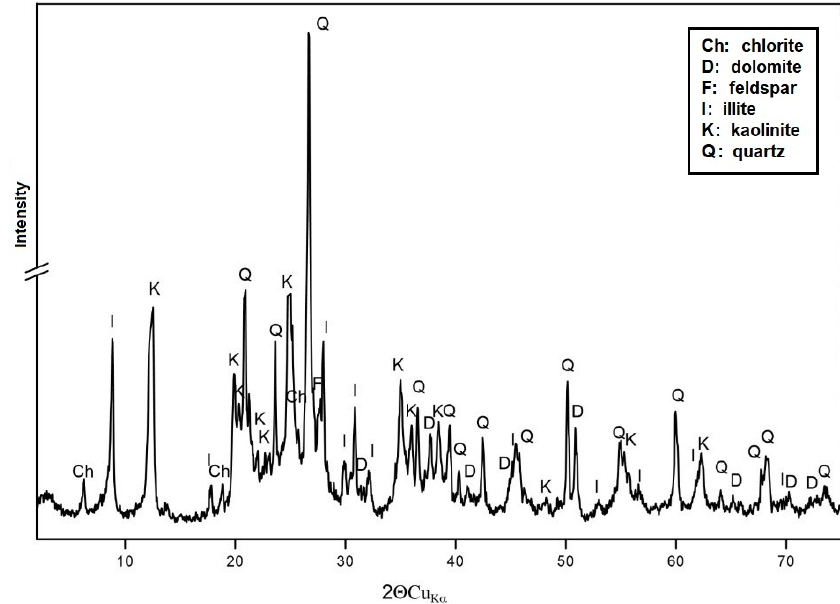
Figure 5. Diffractogram of sample RM.